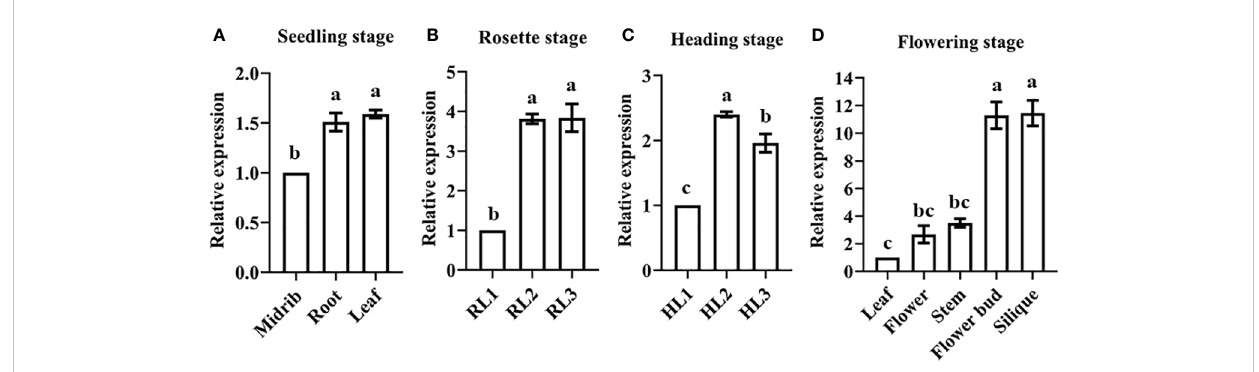
FIGURE 2 BR1 expression patterns during different developmental stages in Chinese cabbage. BR1 expression was assessed in the (A) seedling, (B) rosette, (C) heading, and (D) fl owering stages. Data are means ± SE of three independent measurements. Statistically distinct groups are marked with black letters (one-way ANOVA, p < 0.05).